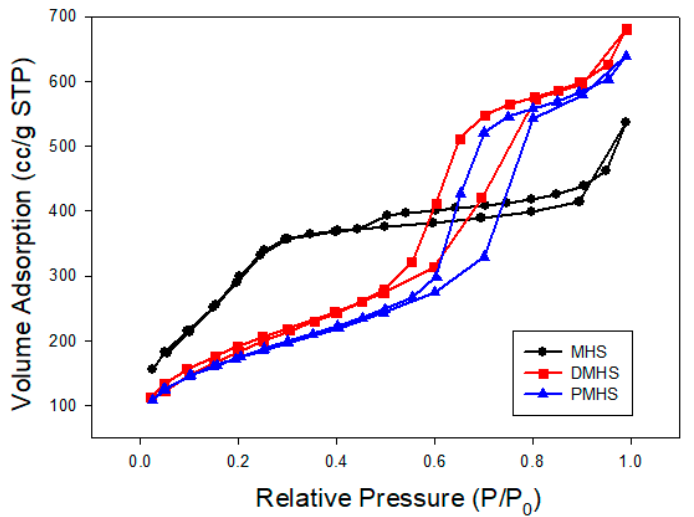
Figure 2. N 2 adsorption–desorption isotherms for MHS, PMHS, and DMHS. The adsorption and desorption curves were separated at the point where the relative pressure was 0.5, therefore confirming the mesoporous morphology. The BET-specific surface area of MHS was 1164 m 2 /g, and those of PHMS and DMHS were 609 and 690 m 2 /g, respectively. Although there was a significant difference in the specific surface area, isotherm graphs, indicating superior pore formation than MHS.